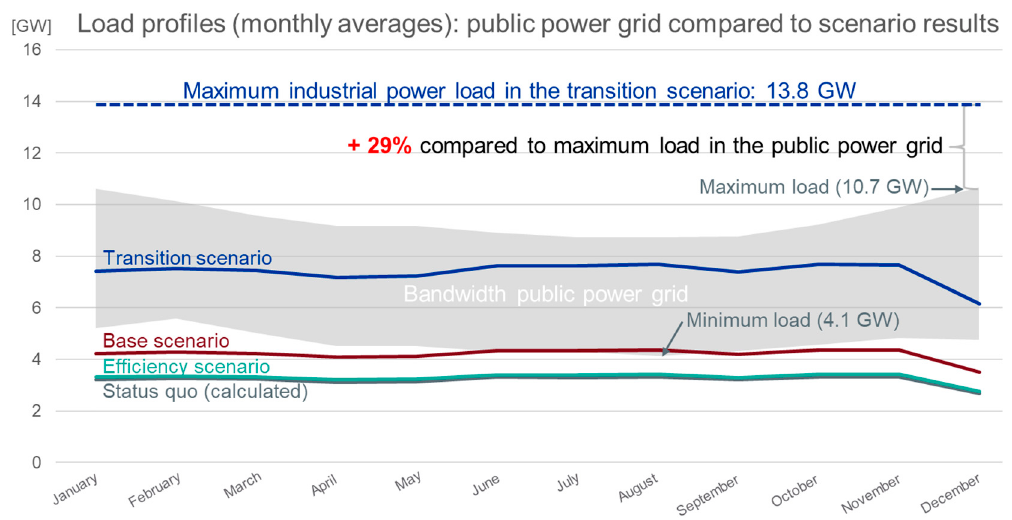
Figure 7. Comparison of the load curve in the public power grid (2019, in grey) [42] and the scenario results.